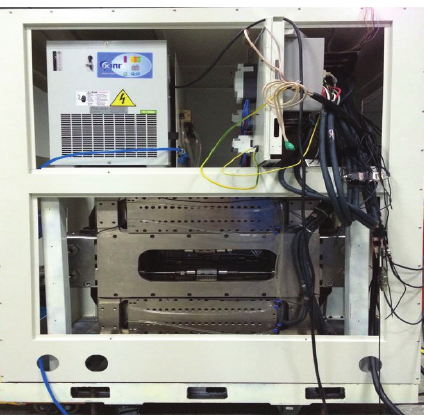
Figure 2: Linear-motor-driven water piston pump system.